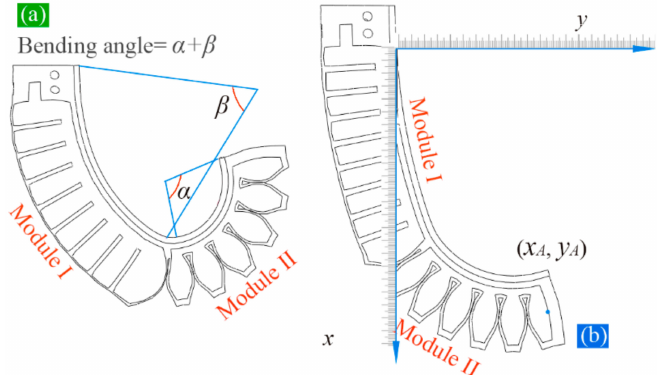
Figure 3. ( a ) Definition of the bending angles and ( b ) a schematic diagram for the measuring of the motion